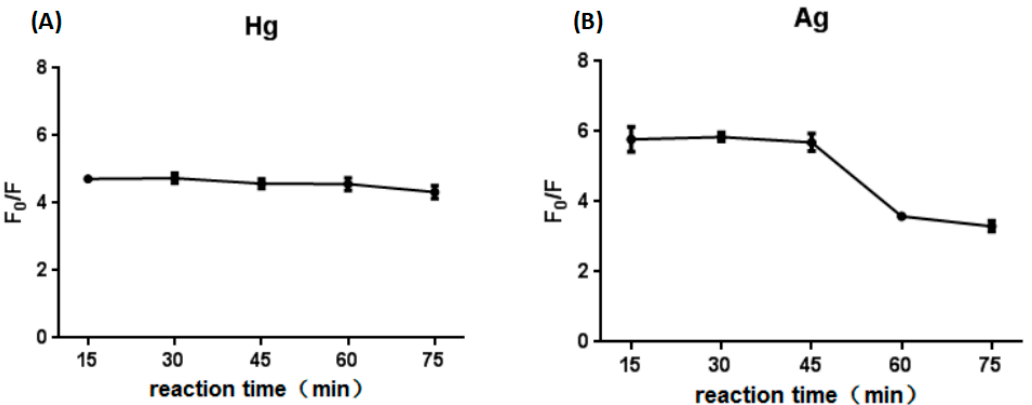
Figure 5. Optimization of the reaction time in the presence of Hg 2+ ( A ). Optimization of the reaction time in the presence of Ag + ( B ).